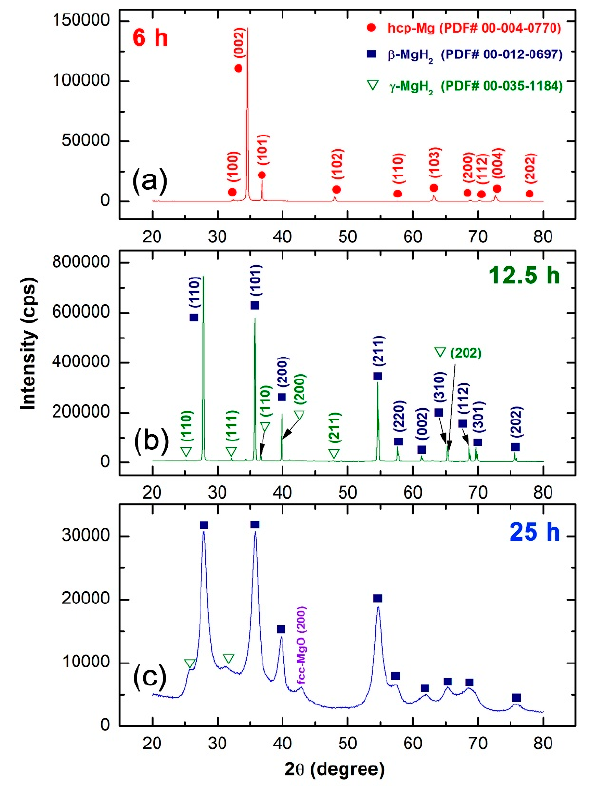
Figure 3. XRD patterns of hcp-Mg powders obtained after ( a ) 6 h, ( b ) 12.5 h and ( c ) 25 h of RBM time, using Zr 2 Ni balls.